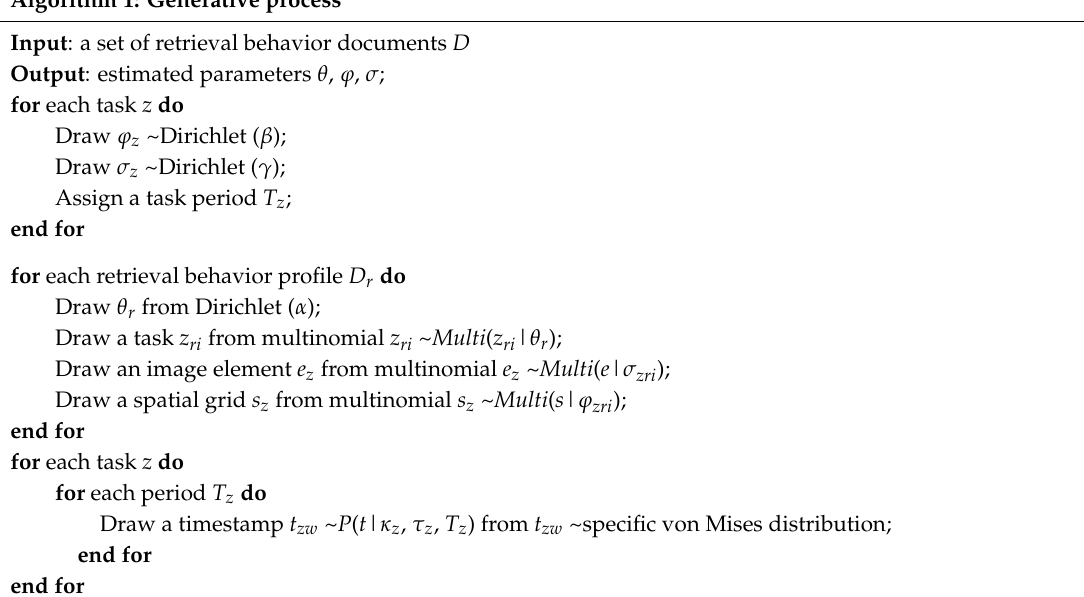
Algorithm 1: Generative